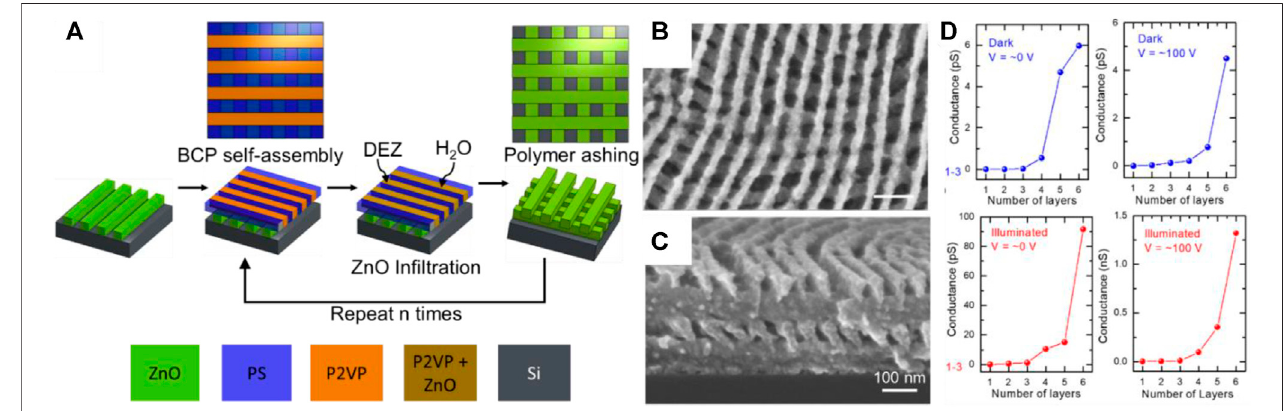
FIGURE7|(A) Schematicdescription ofZnOnanomesh structure fabricationprocedures exploiting recursive spontaneousorthogonal alignmentoflamellar BCP; SEM micrographs illustrating (B) Top-view and (C) Cross-sectional view of 4-layer ZnO nanomesh; (D) differential conductance of ZnO nanomesh with respect to the